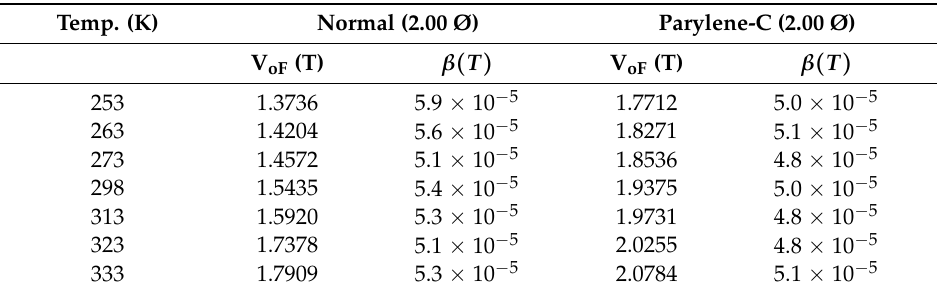
Table 2. Values of initial voltage and gas absorption coefficients at various temperatures. Temp. (K) Normal (2.00 Ø) Parylene-C (2.00